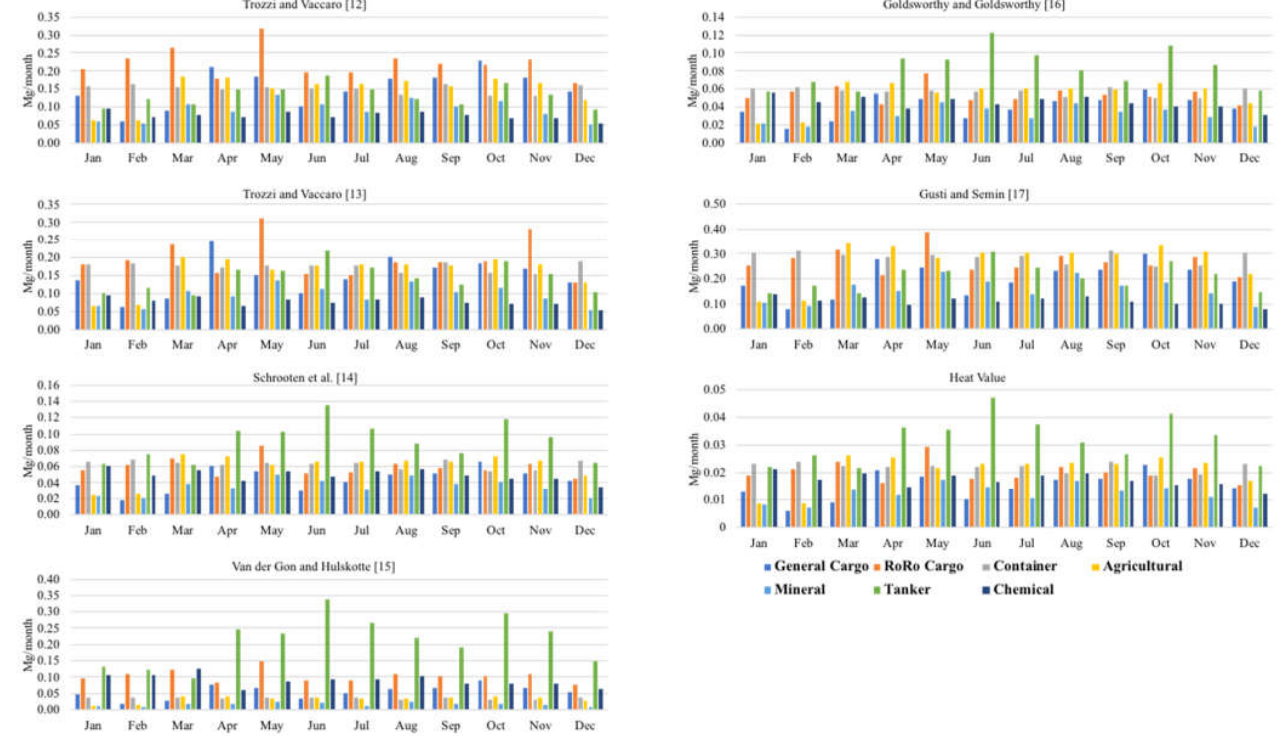
Figure 11. Monthly distribution of average SO 2 emissions (Mg) by type of vessel and method.